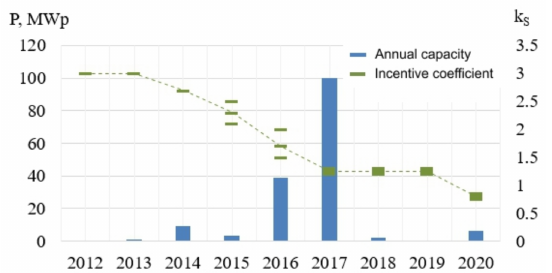
Figure 3. Dynamics of annual commissioning volume of solar power plants in Belarus, and maximum incentive